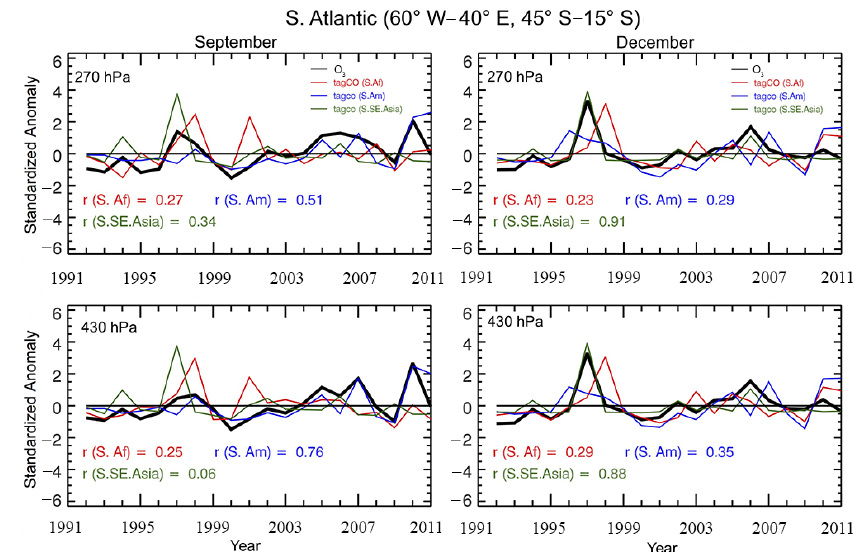
Figure 9. The standardized anomalies of the tagged CO tracers over the South Atlantic from three burning source regions, including southern Africa (red), South America (blue), and South and Southeast Asia (green), and their comparison with the EmissO 3 (black) at 270 and 430hPa in September and December from 1992 to